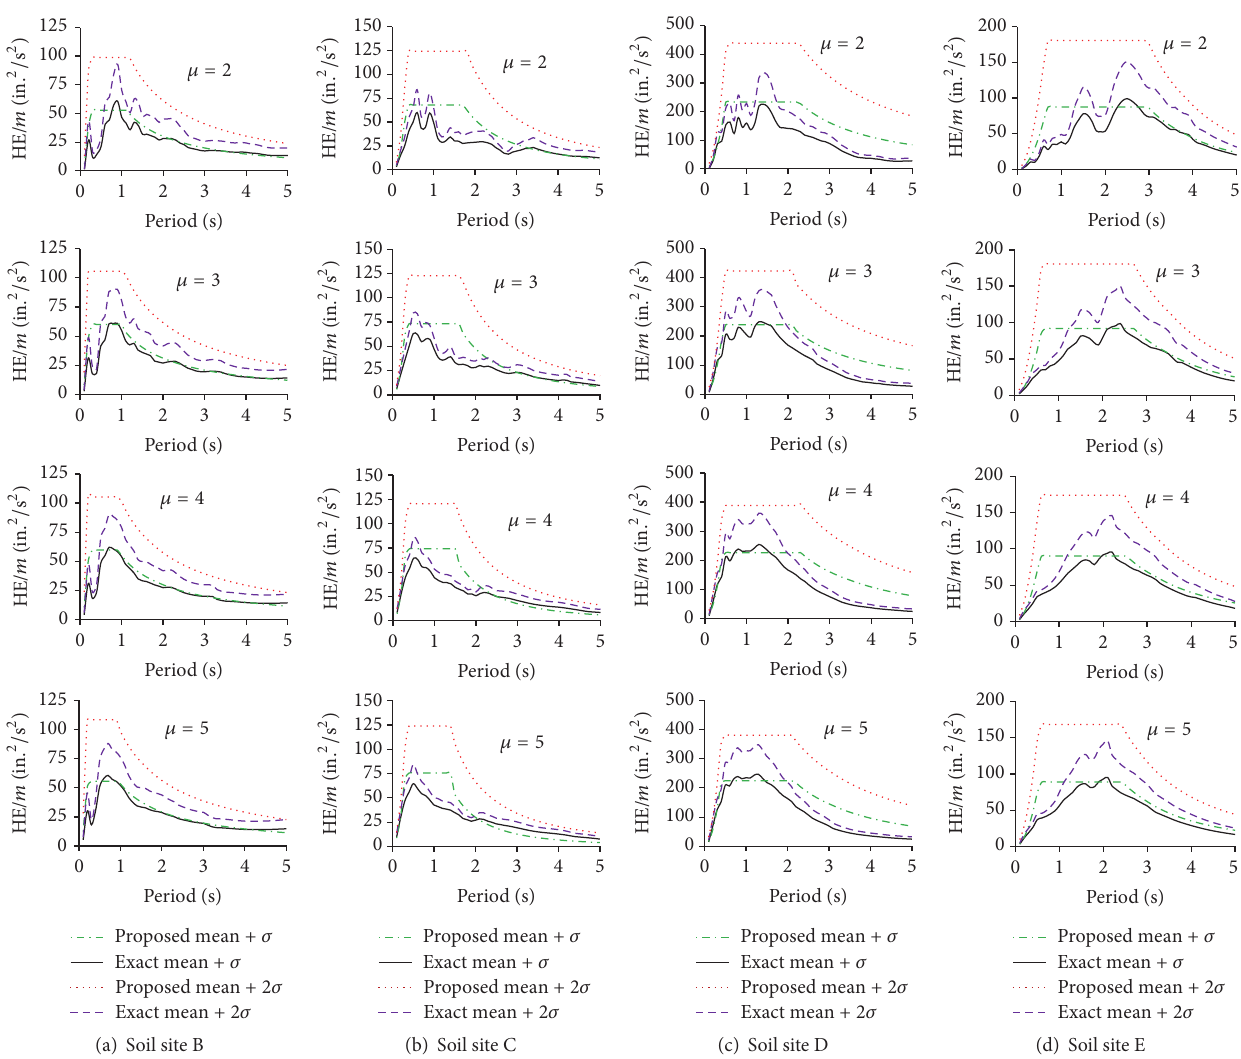
Figure 13: Comparative study of proposed hysteretic energy spectra: hysteresis model